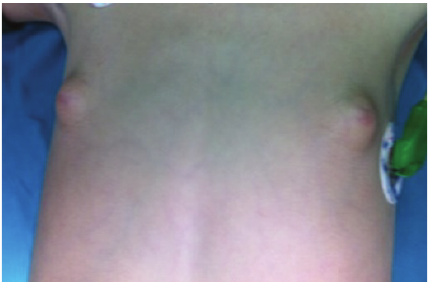
Figure 1: Bilateral gynecomastia.